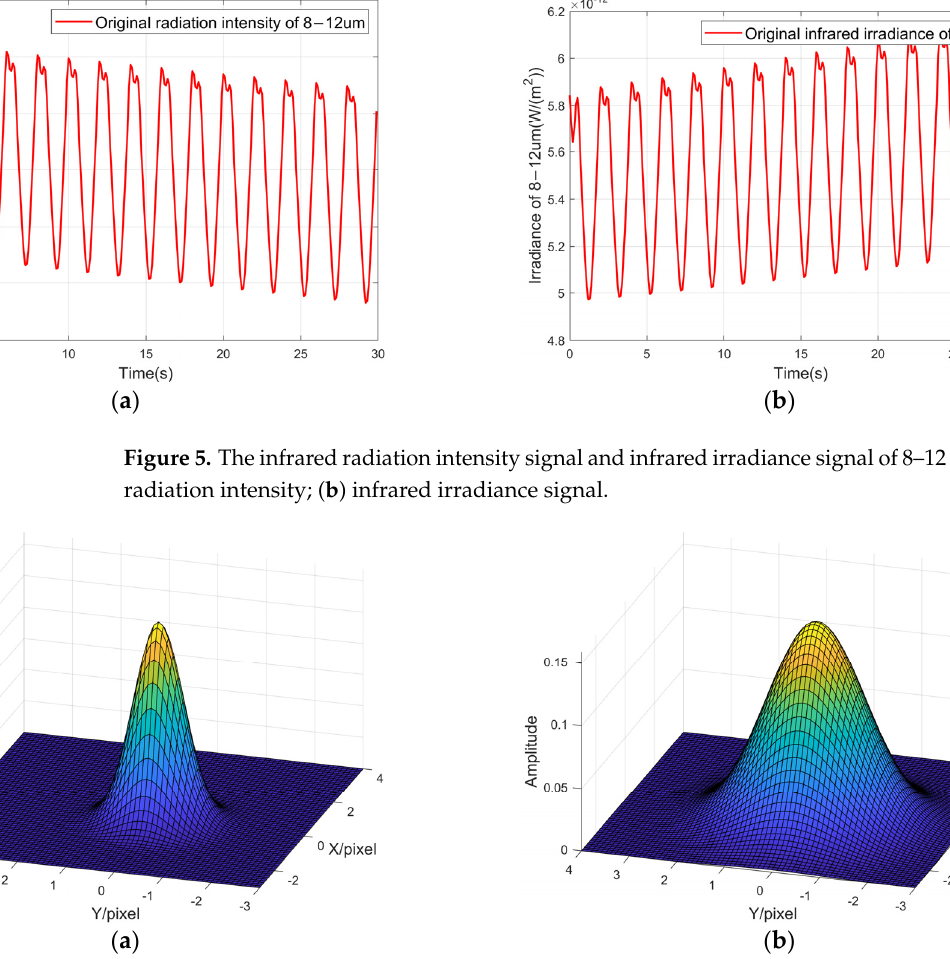
Figure 6. Dispersion effect distribution diagram of point target ( a ) dispersion radius of 1.5 pixels; ( b ) dispersion radius of 2.5 pixels.